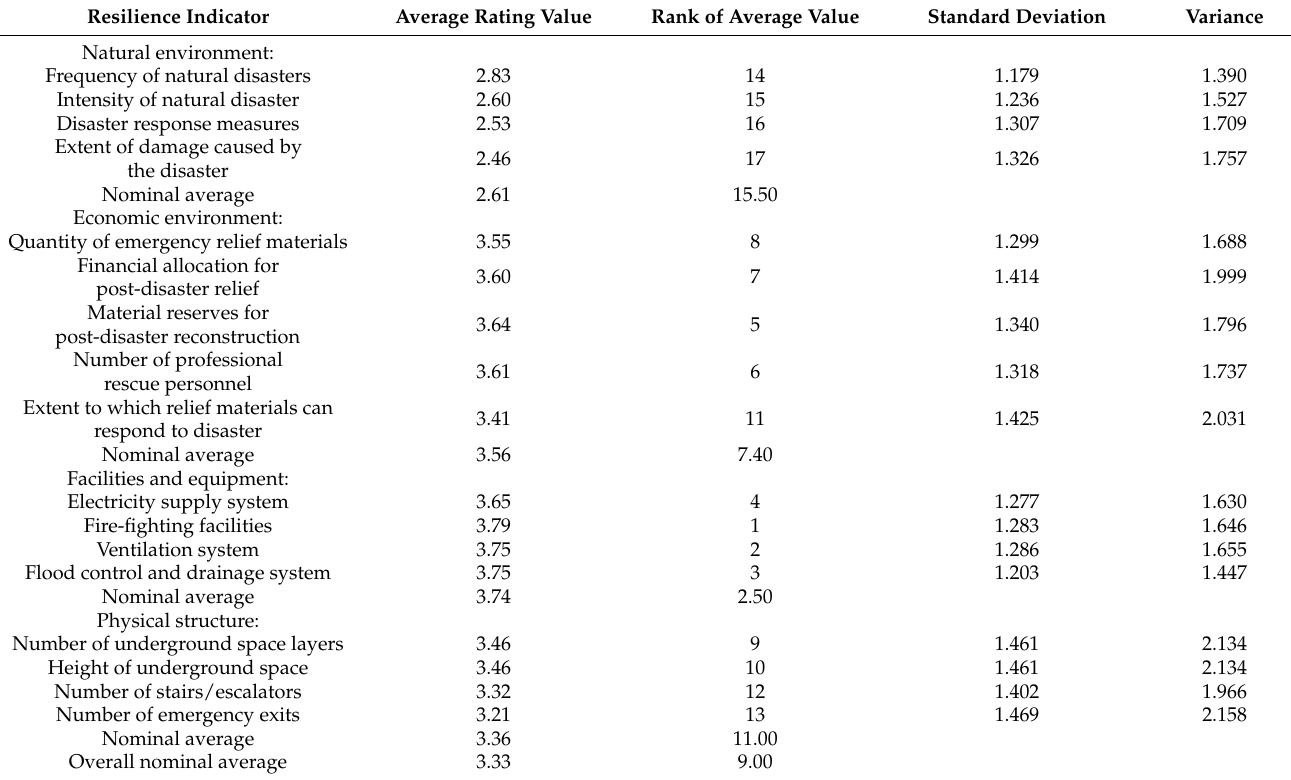
Table 4. Descriptive statistics of importance rating of 17 resilience indicators (sample size = 250, minimum value = 1 for “Very unimportant, and maximum value of 5 for “Very